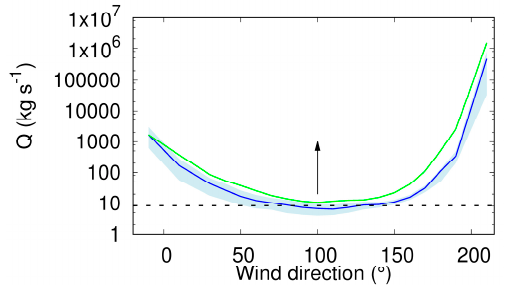
Figure 9. Sensitivity test results showing the inverted CO 2 flux for different presumed wind directions. Fluxes for wind directions between 220° and 360° are positive infinitive and not shown. The envelope depicts , the lower and upper 95% credibility interval (dotted lines in the histogram in Figure 8). The blue line depicts the fluxes for an anticipated vent location at BN, which matches the flux from direct integration (dotted line) for angles between ~80° and ~140°. The green line depicts the result of a second such test for an effective vent location halfway between BN and BG with increasing trend, indicated by the arrow, not matching fluxes from direct integration.